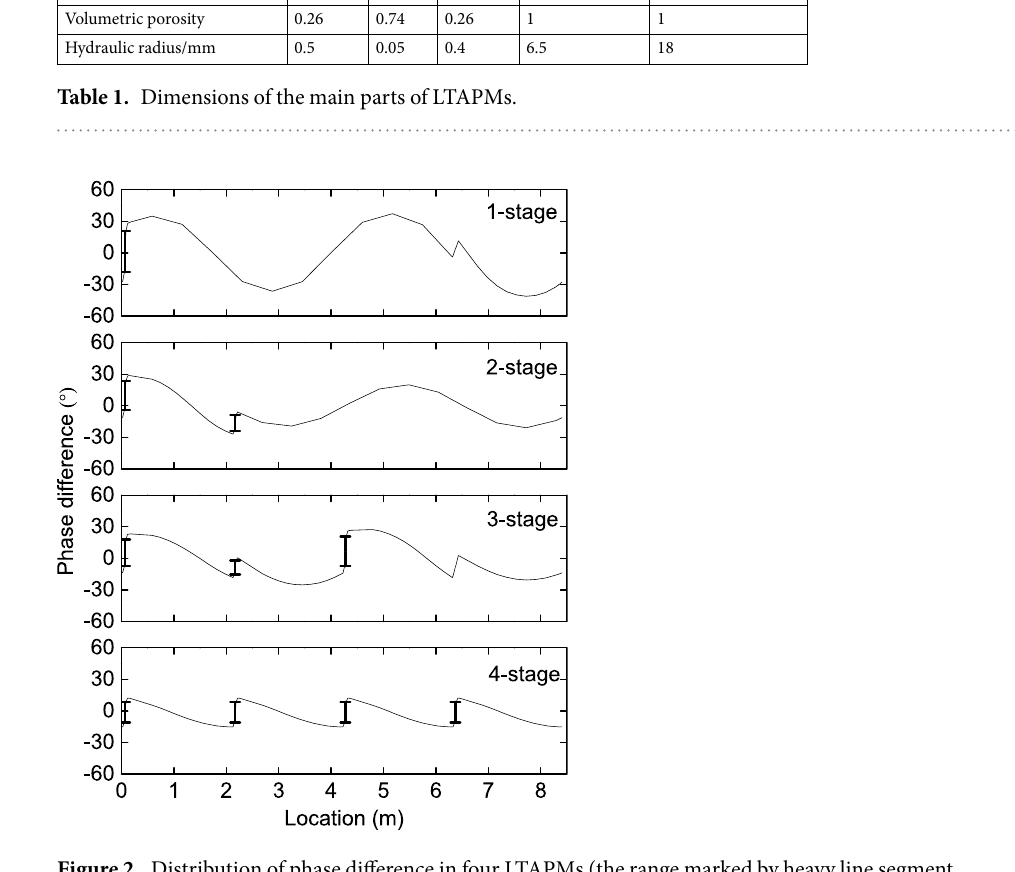
Figure 2. Distribution of phase difference in four LTAPMs (the range marked by heavy line segment representing the